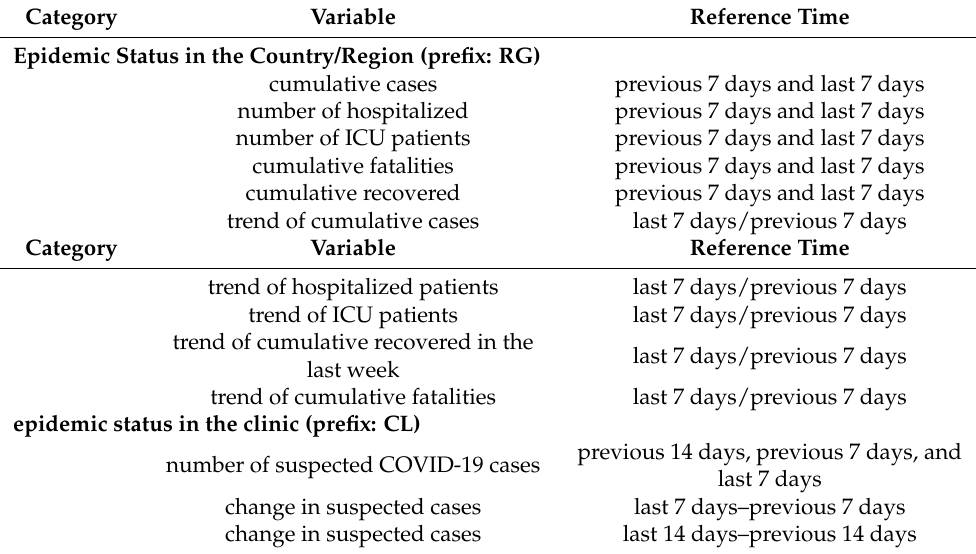
Table A1. Variables included in the